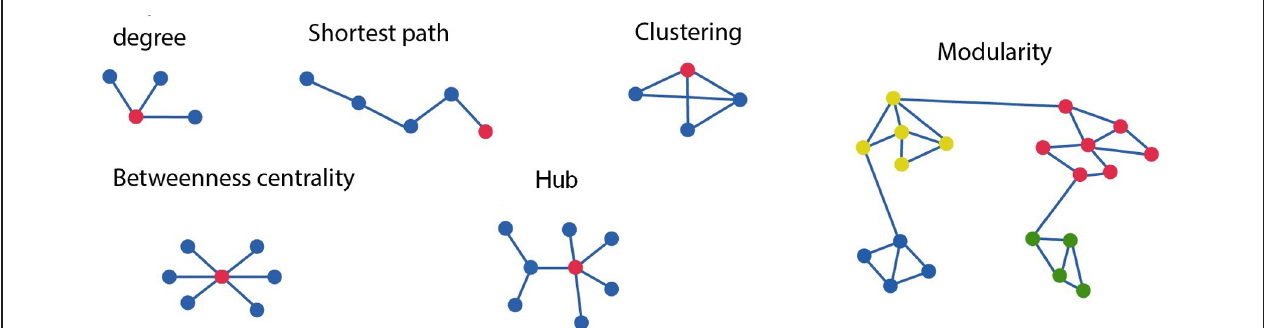
the red node and final blue corresponds to four. On the bottom row betweenness centrality is the ratio of all shortest paths that pass through and from a node. The connector hub is shown in red as connections between the nodes with the highest degree. The graph at the right consists of four different modules , or clusters specified by the different node color. Modularity refers to the existence of clusters of nodes with connections which are more densely connected to other nodes within the same module than to nodes outside the module.